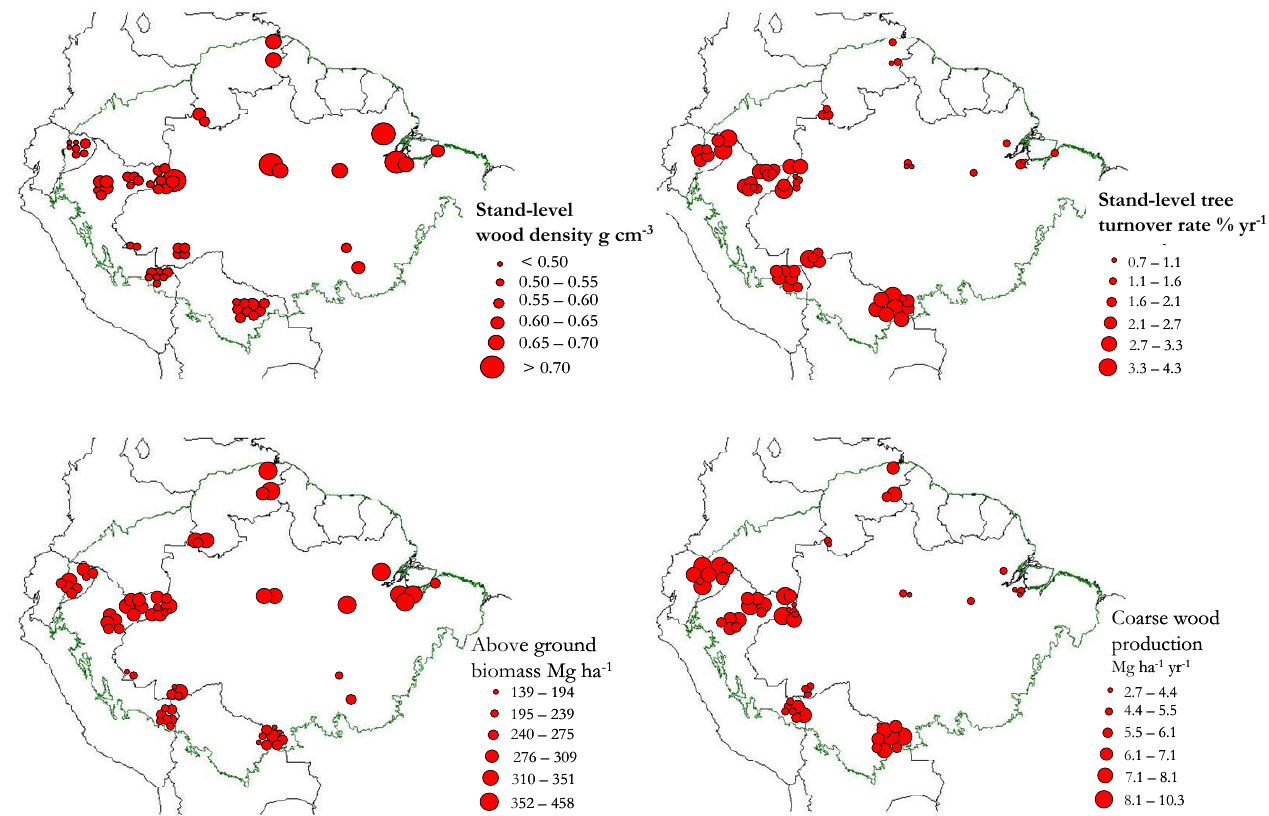
Fig. 1. Geographical distribution of stand-level wood density ( % w ), stand-level tree turnover rates ( ϕ ), above-ground biomass ( B ) and above- ground coarse wood production ( W P ) across the Amazon Basin. Size of circles represents relative